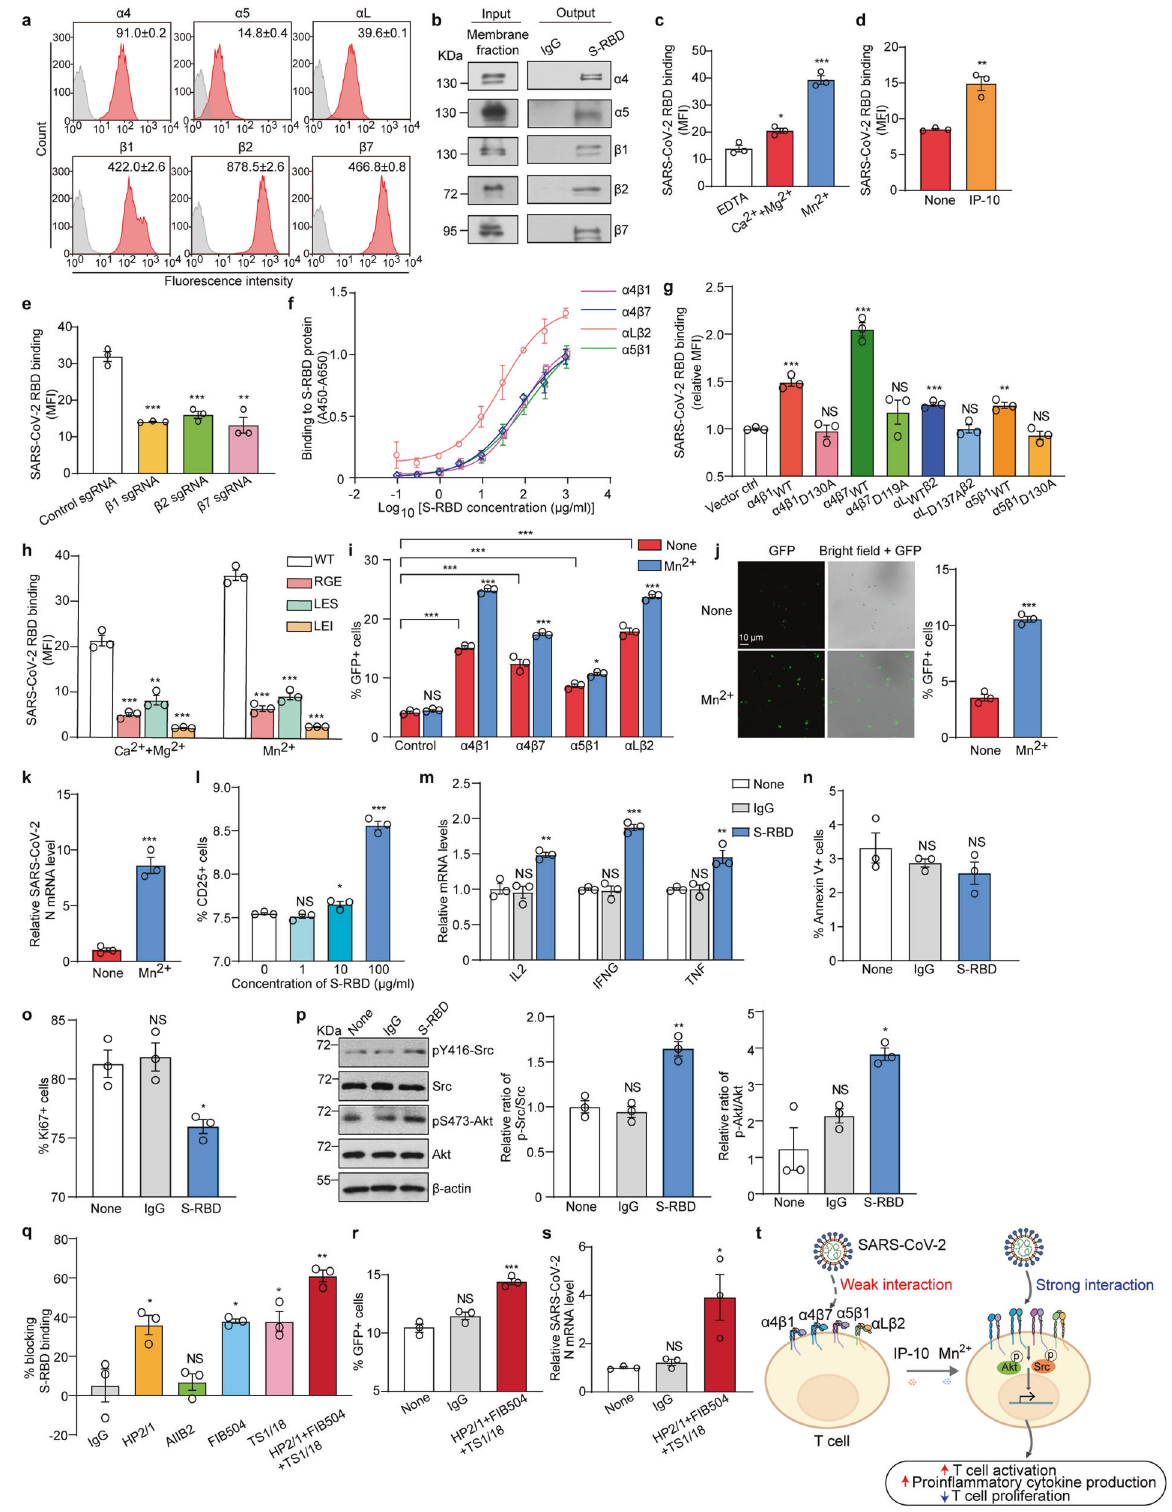
MIDAS in mediating S-RBD ‒ integrin binding, we abolished the metal ion binding in MIDAS of β 1, β 7, and α L subunits by mutating the metal ‐ coordinating residues to Ala. The wild-type (WT) or